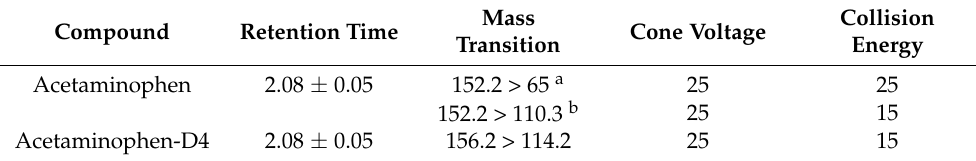
Table 1. Multiple reaction monitoring transitions and mass spectrometry parameters. Compound Retention Time